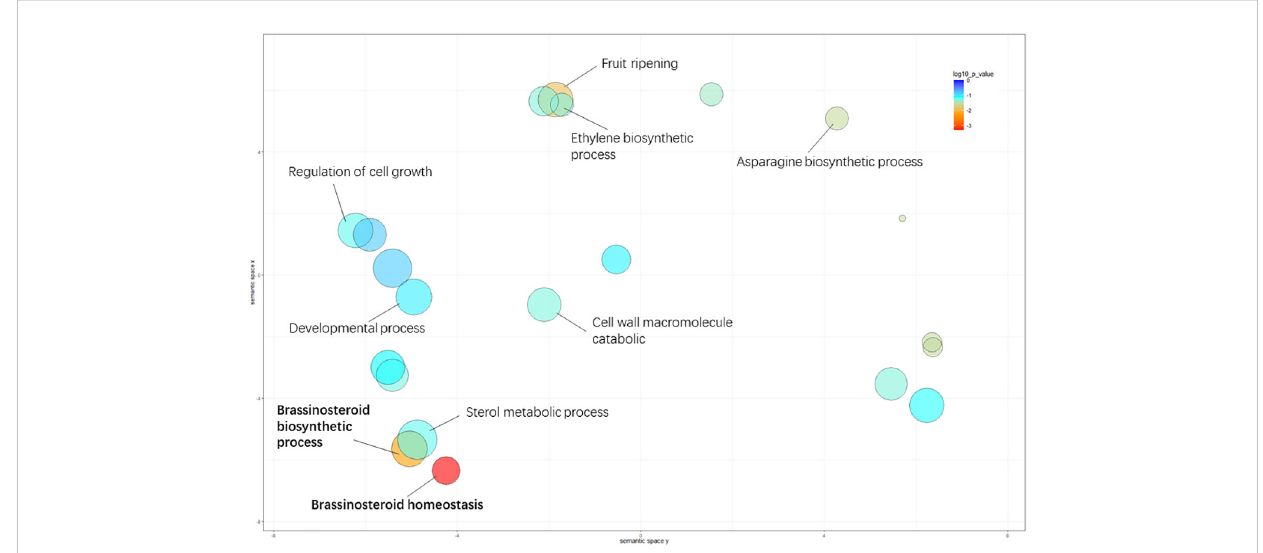
FIGURE 3 Signi fi cantly enriched GO terms in the comparison of L- vs. S-morph styles. The circle color represents the log10 transformed p-value in REVIGO analysis. The circle color represents the log10 transformed p-value in REVIGO